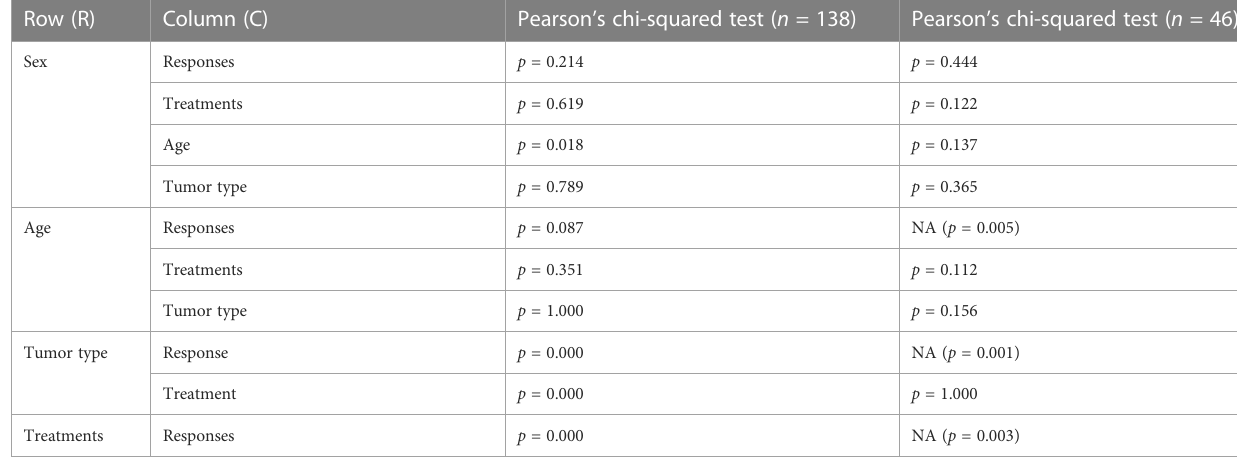
TABLE 4 Sex, age, tumor type, and treatment strategy in fl uences in gd T cell immunotherapy ( n =